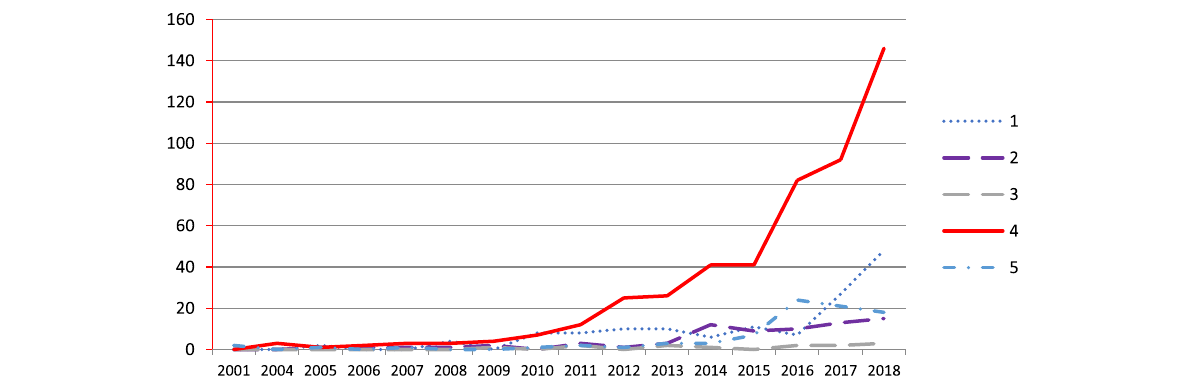
Fig. 4 Publication distribution in terms of content scope being focused on over the